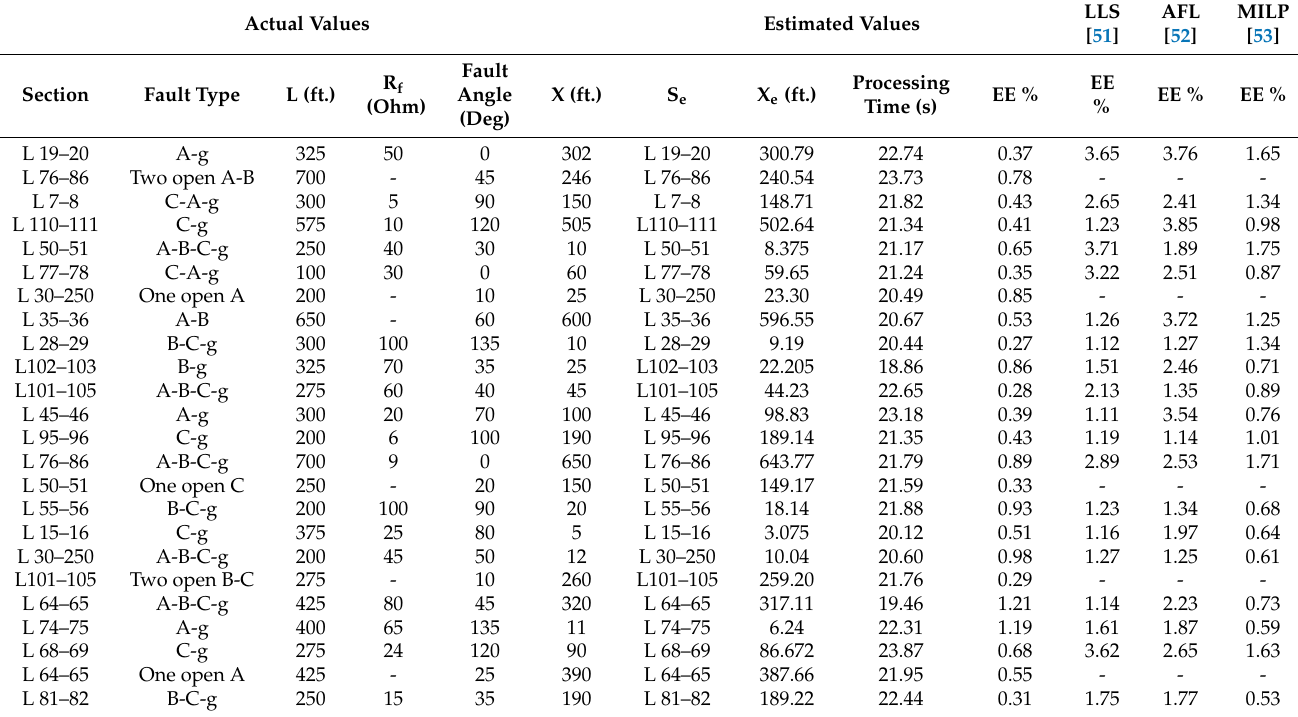
Table 1. Comparison of the results of the proposed